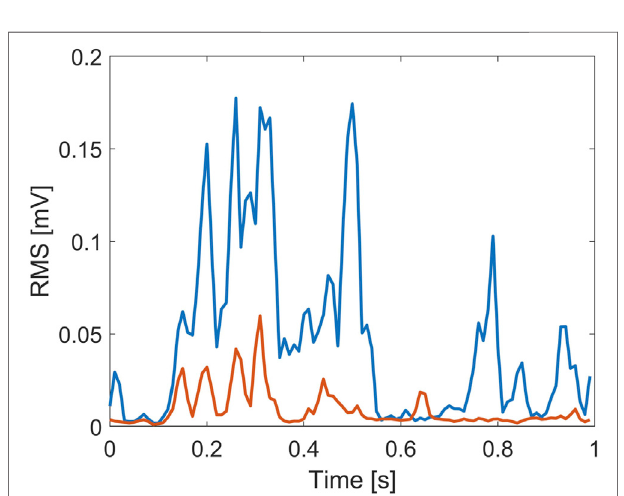
FIGURE5| Rootmeansquare(RMS)valueofthemyoelectricactivity for the tibialis anterior (red line) and gastrocnemius (blue line) recorded during the EC trial, from a representative subject.